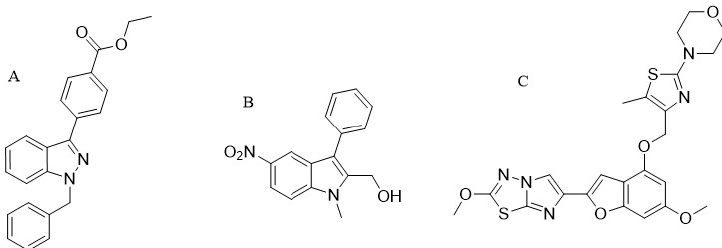
Figure 3. Low molecular weight PAR4 antagonists. ( A ) YD-3 [1-benzyl-3(ethoxycarbonylphenyl)- indazole], PubChem CID (10132921); ( B ) ML354 (1-methyl-5-nitro-3-phenyl-1 H -indole-2-methanol),